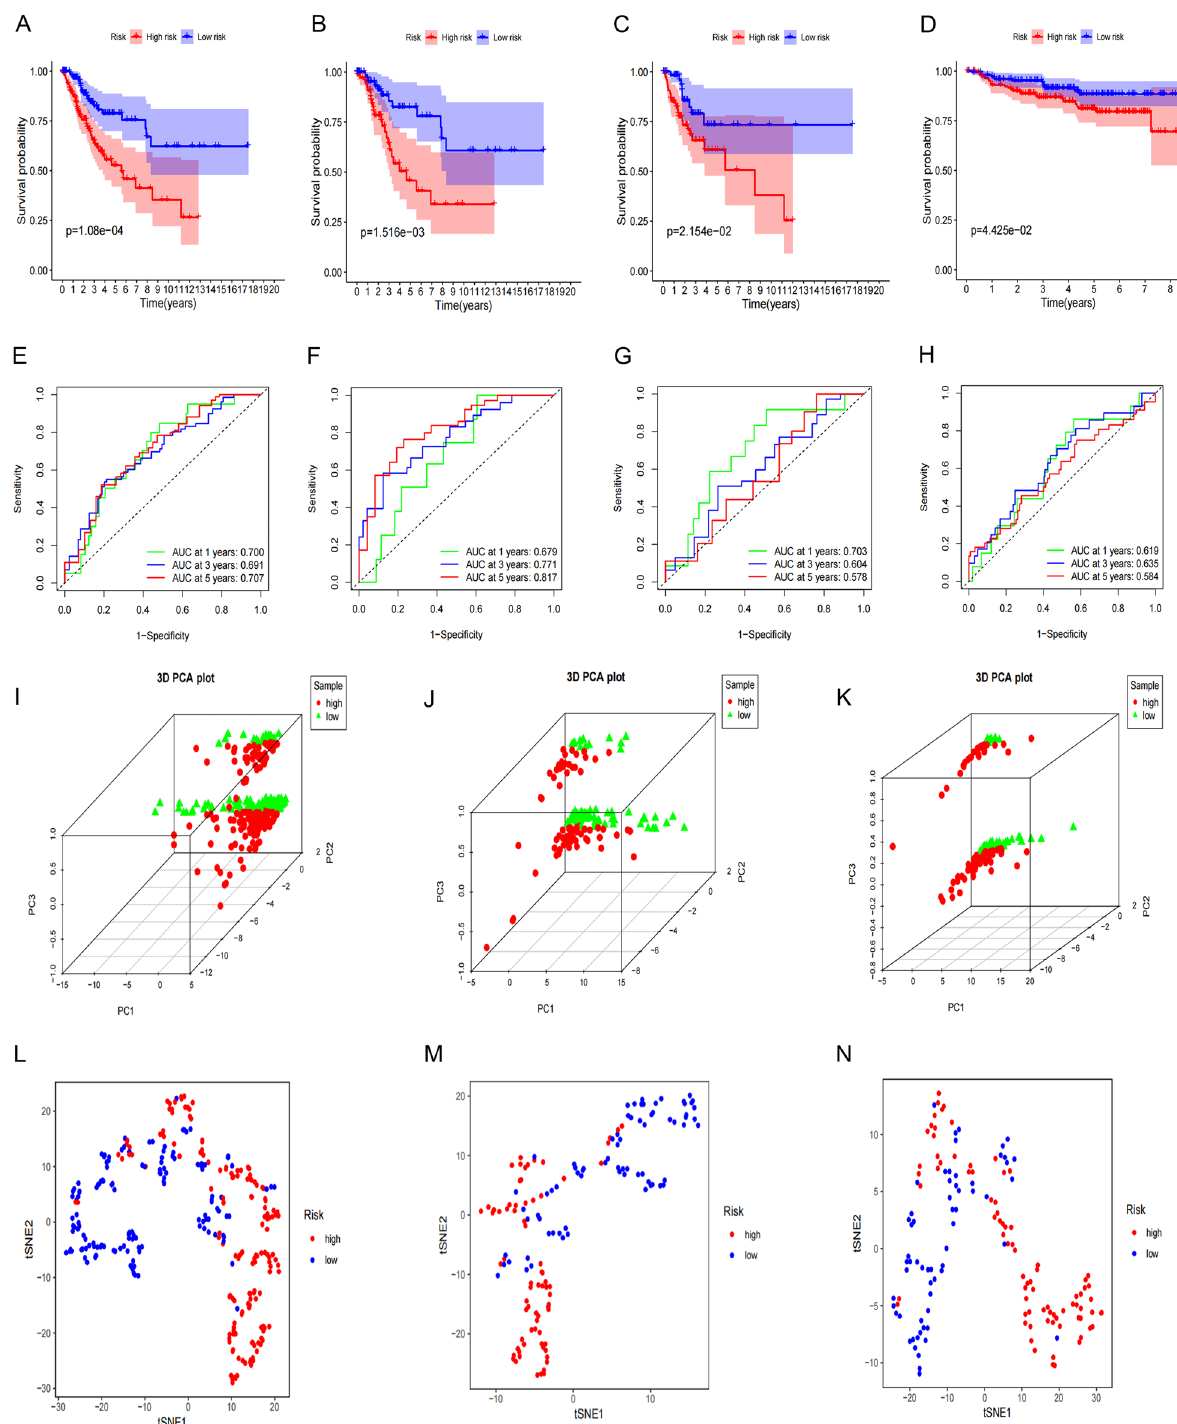
Figure 7. Relationship between the risk scores and clinicopathological factors. Kaplan–Meier curves were created to estimate OS for high- and low-risk groups from TCGA cohort ( A ), the two validation data sets ( B – C ) and GEO database ( D ); ( E – H ) TimeROC curves with two sets of validation datasets and GEO database; ( I – N ) Results of the principal components and t-SNE analysis in the TCGA